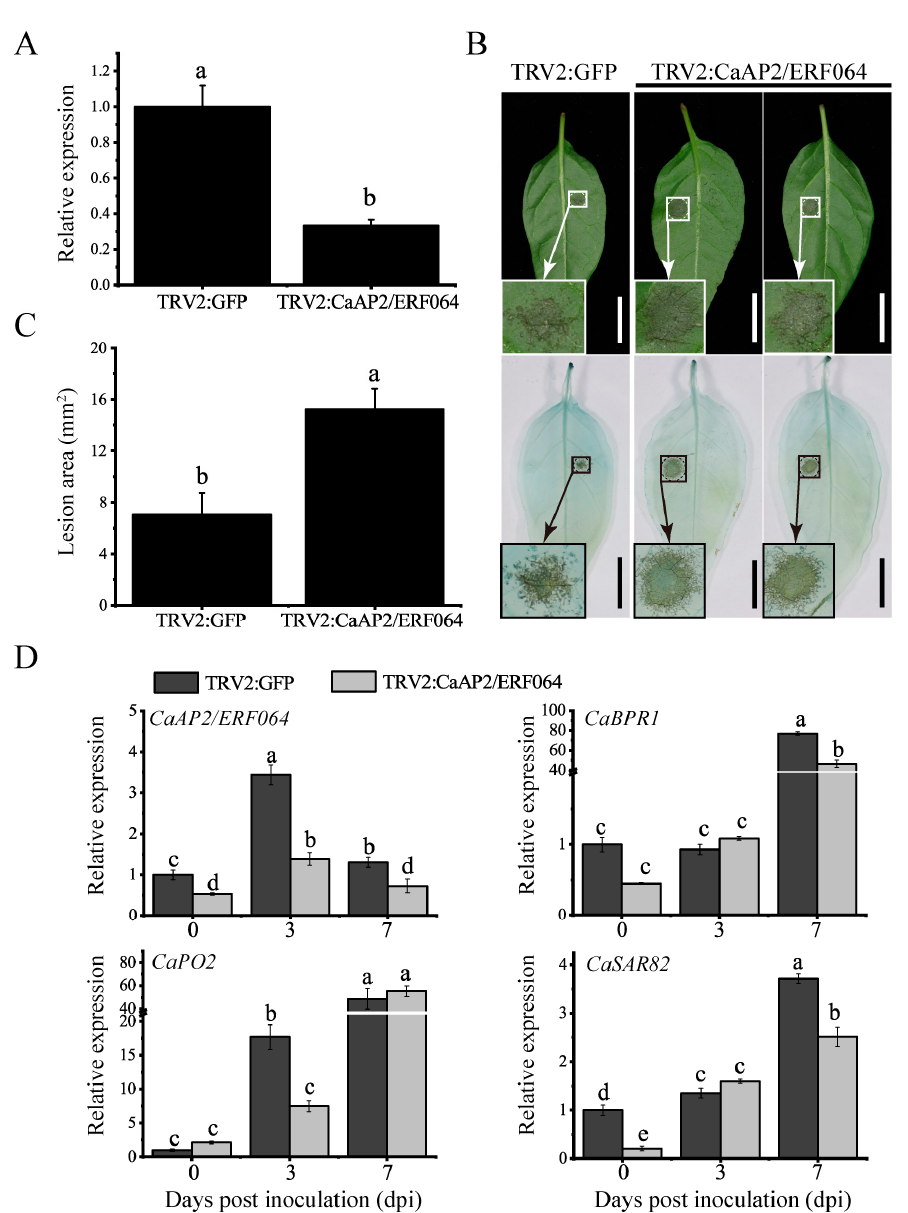
Figure 5. Virus-induced gene silencing (VIGS) of CaAP2/ERF064 in pepper enhanced susceptibility to P. capsici infection. ( A ) Silencing efficiency of CaAP2/ERF064 in silenced and control plants. ( B ) Disease symptom on pepper leaves at 4 dpi. ( C ) Analysis of leave lesion and quantified using ImageJ software. ( D ) Expression analysis of defense-related genes in CaAP2/ERF064 -silenced and control plants. Values are means ± SD. Small letters indicate a significant difference (LSD, p < 0.05).